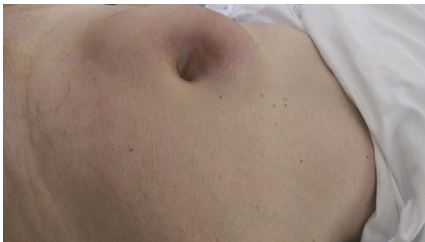
Figure 1: Asymptomatic mass of 12 × 6cm ( CC × AP ) in the mesogastrium with petrous consistency.